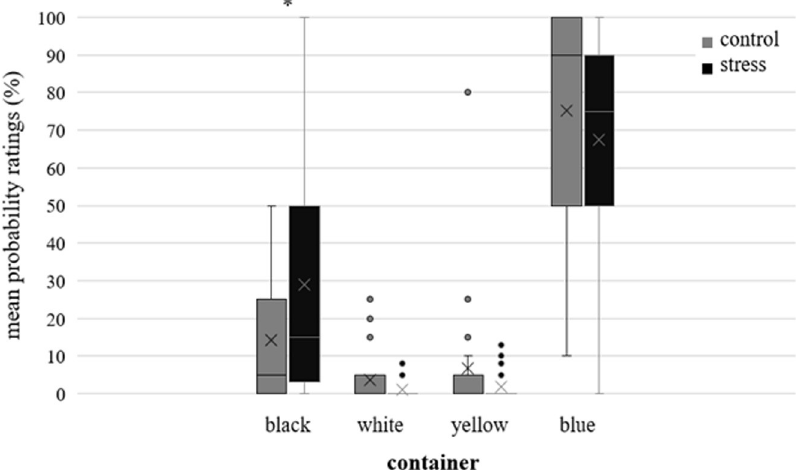
Fig 3. Boxplots representing the ratings of the probability that Niklas would look into the black, white, yellow, or blue container first. The lower and upper box boundaries represent the lower and upper quartiles, respectively. The horizontal line inside the box represents the median. When no horizontal line is present inside a box, the median is 0. The cross represents the mean. The lower and upper whiskers represent minimum and maximum scores, respectively. Dots outside the box represent values that deviate from the upper quartile by more than 1.5 times the interquartile range.